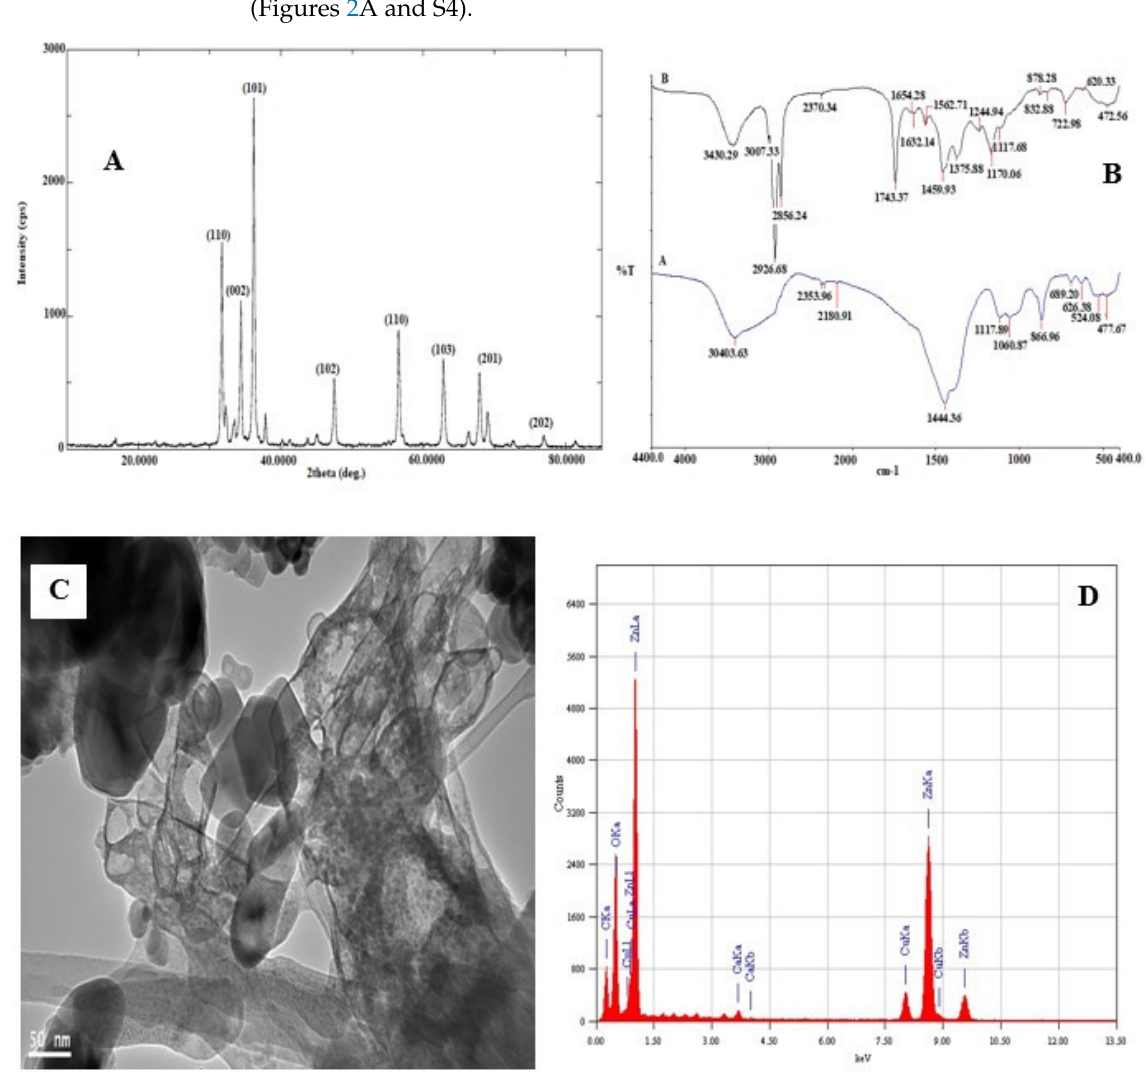
Figure 2. ( A ) X-Ray diffraction pattern and diffraction angles peaks of synthesized ZnO NPs–NLC. ( B ) FT-IR spectra of synthesized ( A ) ZnO NPs ( B ) ZnO NPs–NLC. ( C ) TEM micrograph and ( D ) EDX spectrum of synthesized ZnO NPs.